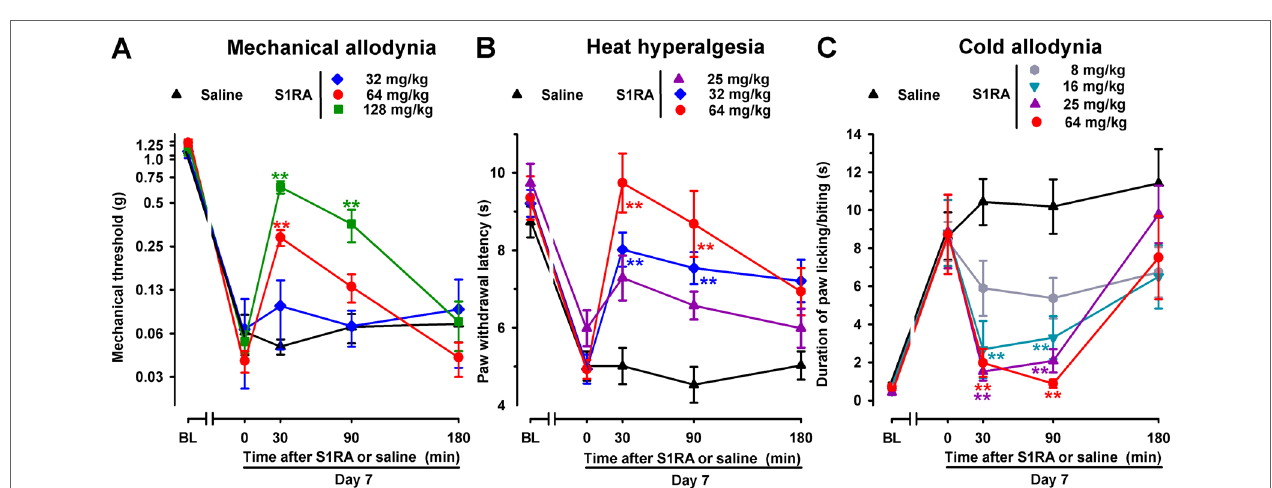
FIGURE 3 | Time course of the effects of a single subcutaneous (s.c.) injection of S1RA (8–128 mg/kg) or saline on mechanical allodynia (A) , heat hyperalgesia (B) , and cold allodynia (C) , in female WT mice with SNI, 7 days after surgery. The von Frey threshold (A) , the latency to hind paw withdrawal in the Hargreaves test (B) , and the duration of hind paw licking or biting in the acetone test (C) were recorded 1 day before (baseline, BL) and 7 days (Day 7) after surgery in the paw ipsilateral to the surgery. On day 7, the responses to test stimuli was recorded immediately before (time 0) and at several times (30, 90, and 180 min) after injection of the drug or saline. Each point and vertical line represent the mean ± SEM of the values obtained in 8–11 animals. Statistically significant differences between S1RA- and saline-treated groups at the same time after treatment: ** P < 0.01 (two-way repeated-measures ANOVA followed by Bonferroni